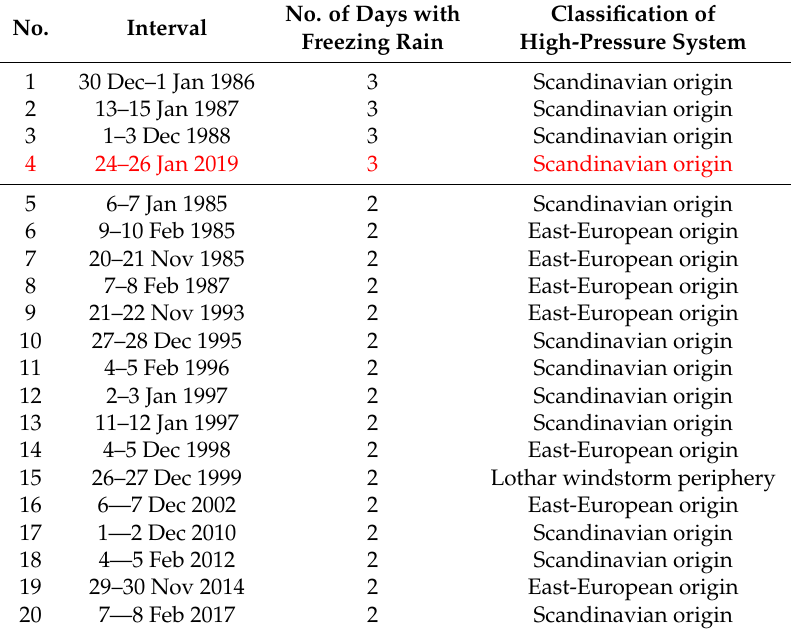
Figure 8. The composite maps of the two main synoptic patterns for prolonged freezing rain events: ( a ) the Scandinavian pattern, ( b ) the East European pattern, ( c ) lee cyclones corresponding to the Scandinavian pattern and ( d ) lee cyclones corresponding to East European pattern. Mean sea level pressure (black contours) and 2 m temperature (shaded according to the scale). Table 1. Classification of the moderate (2 consecutive days) and long-duration (3 consecutive days) freezing rain events in Bucharest based on the origin of the high-pressure system. The event analyzed in this article is indicated in